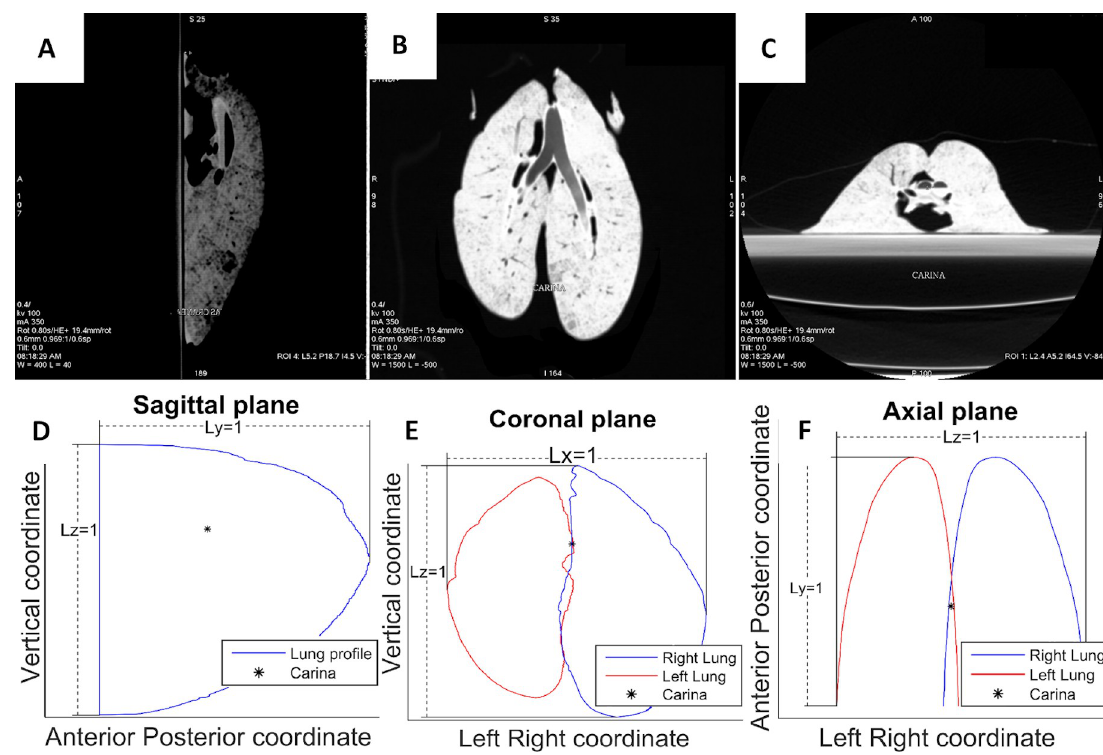
Fig 3. Normalized contour lines obtained from CT-scan images. Contour lines were obtained from CT-scan images and used for a 3D computational reconstruction of the pulmonary surface. Trachea division point (carina) is marked for purposes of reconstruction. (A) Sagittal plane CT image. (B) Coronal plane CT image. (C) Axial plane CT image. (D) Sagittal plane outline reconstruction. (E) Coronal plane outline reconstruction. (F) Axial plane outline reconstruction.